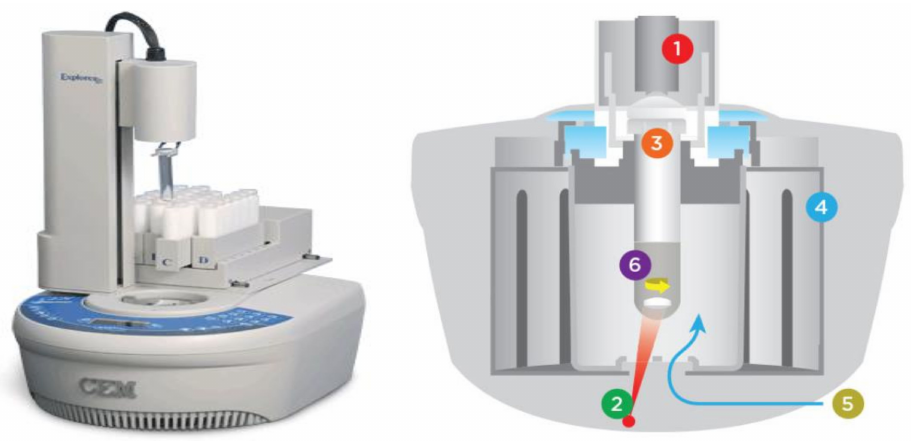
Figure 2. Microwave laboratory apparatus form CEM Corporation Company. 1—Benchmate Pressure Management, 2—Volume-Independent Temperature Sensor, 3—High Temperature/Pressure Sealed Vessels, 4—Self-Tuning, Efficient Microwave Cavity, 5—Compressed Air Reaction Quenching, and 6—Electromagnetic Stirring.